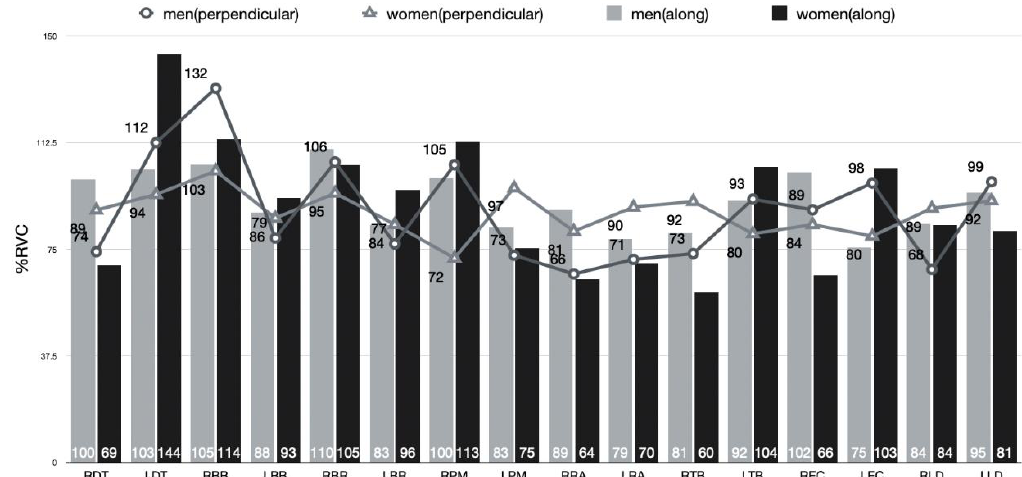
Figure 9. EMG in the pushing motion during sweeping (perpendicular to the axis of motion and along the axis of motion).